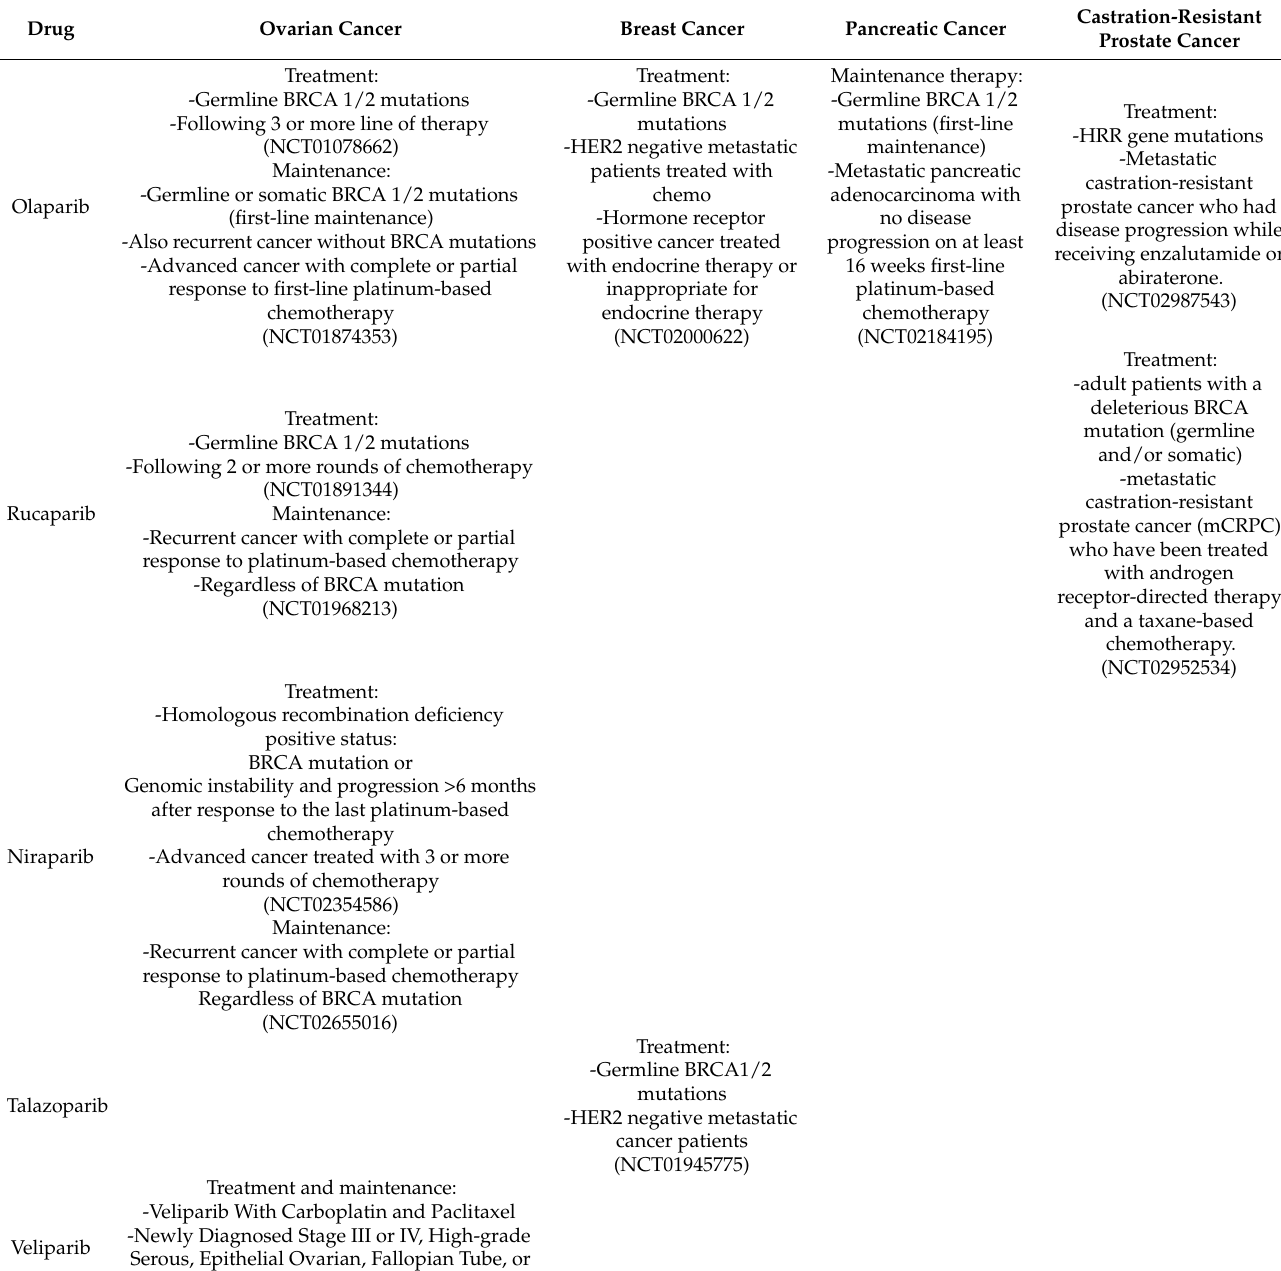
Table 1. PARPis approved for the treatment of progressive disease or maintenance after chemotherapy in HRD cancers (pivotal